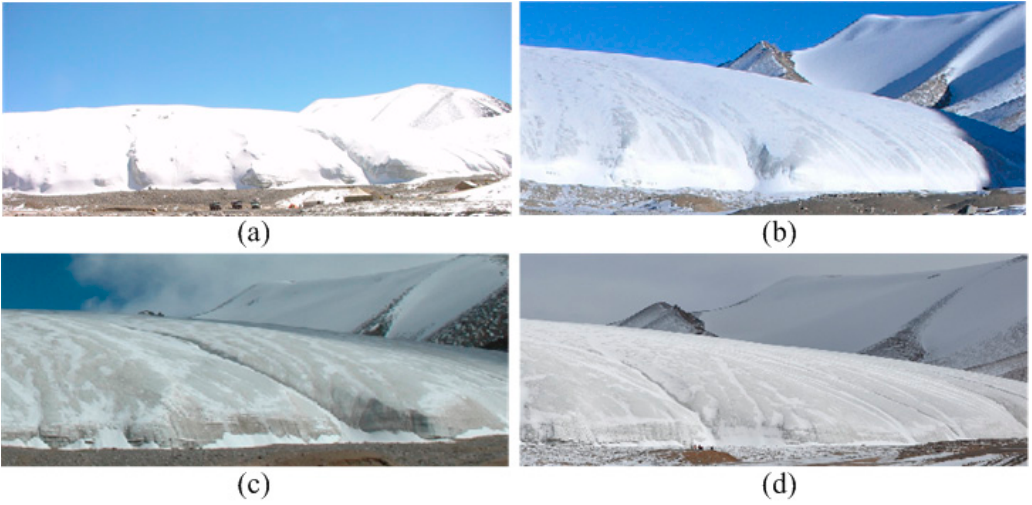
Figure 4. Comparative positions of the glacier front (No. 5Z611A0006) over the past decade: ( a ) 2000; ( b ) 2004; ( c ) 2006; and ( d ) 2012.